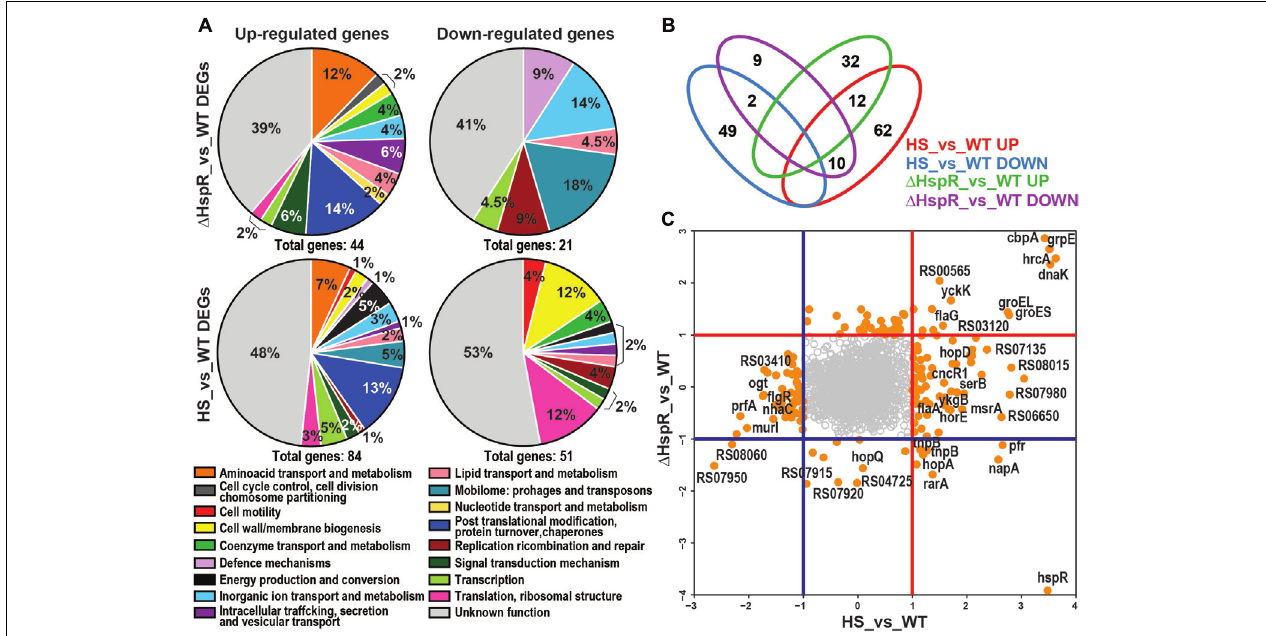
FIGURE 1 | Role of HspR in heat-shock response. (A) Pie charts showing COGs functional annotation of the differentially expressed genes outlined in the (cid:49) HspR_vs_WT and HS_vs_WT (Heat-Shock vs. Wilde Type) comparisons, respectively, subdivided into up-regulated (left) and down-regulated (right) groups. The abundance of each category is indicated as a percentage as well as the total number of genes included in each group. (B) Venn diagram showing the number of genes in common or peculiar in the four previously described gene groups, red numbers highlight commonly regulated genes. (C) log2FC plot showing for each gene HS_vs_WT value on x-axis and HspR_vs_WT value on y-axis. DEGs (log2FC > |1| and p adj < 0.01 are represented as orange filled circles; empty gray circles correspond to non-differentially expressed genes. Blue and red lines indicate log2FC < − 1 and log2FC > 1 thresholds, respectively, subdividing coherently and incoherently regulated